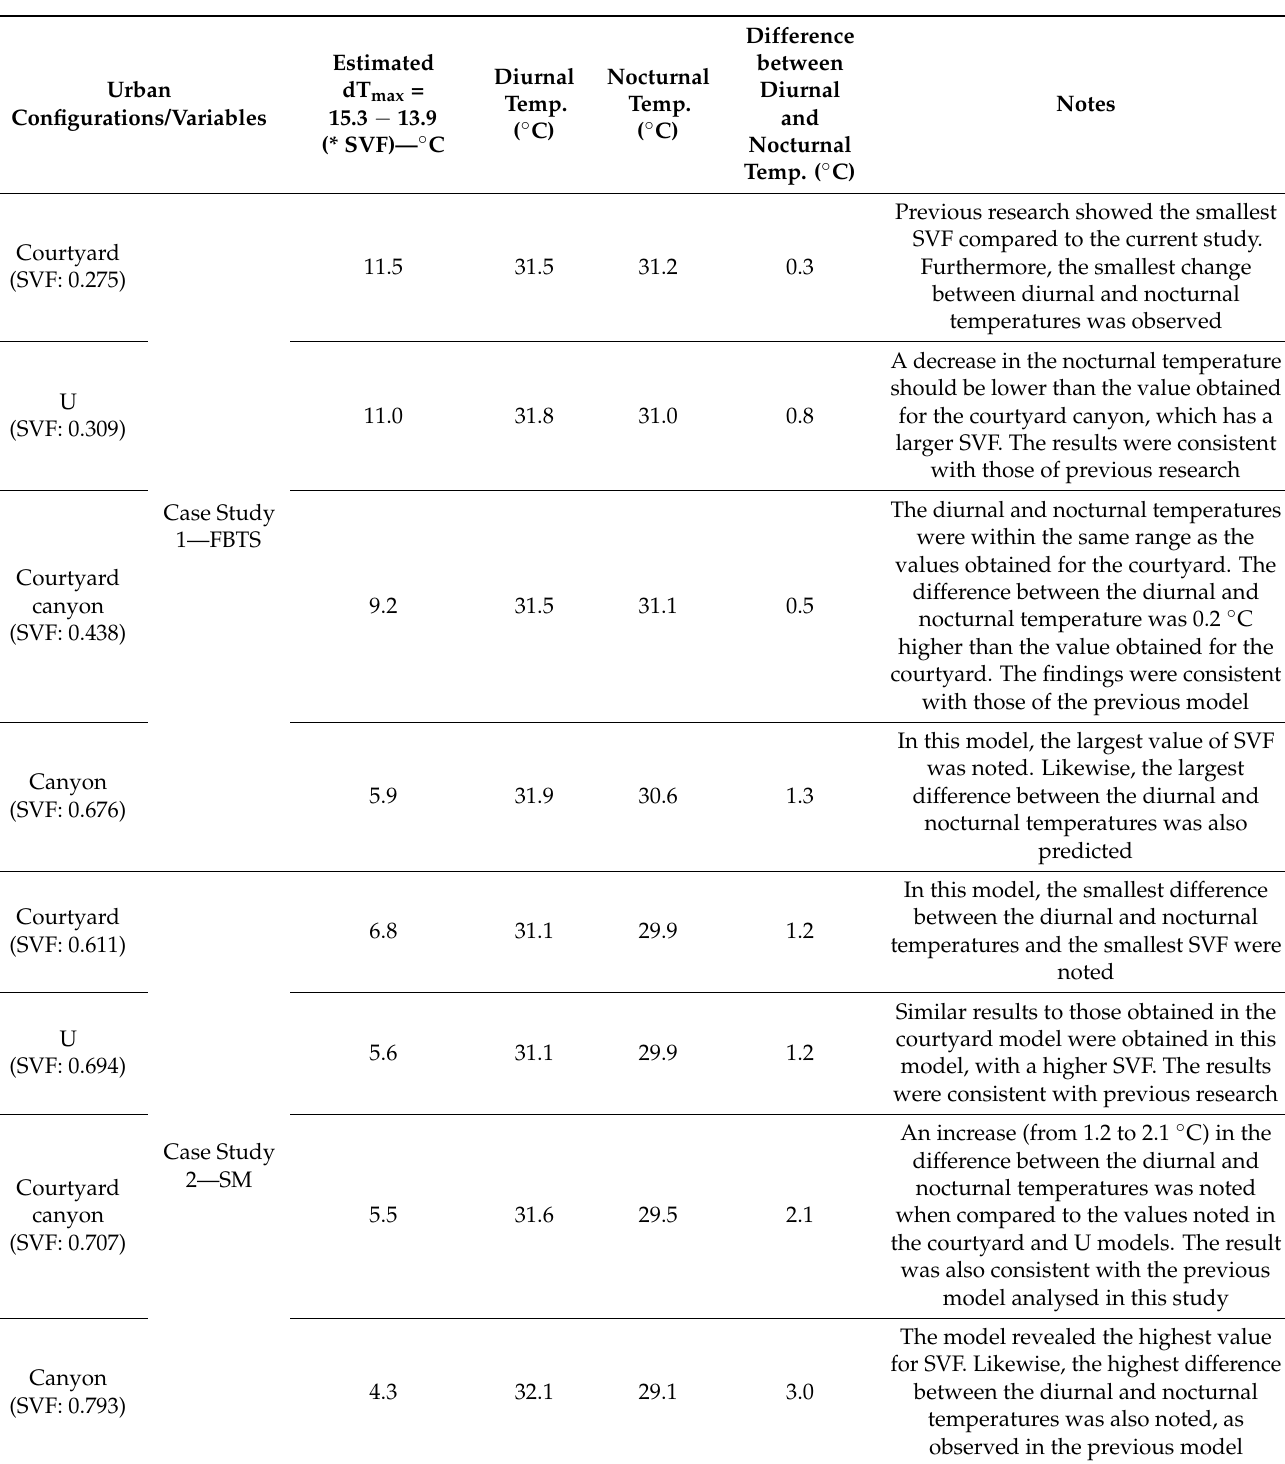
Table 7. Comparison of the simulated air temperatures between the present study and previous research